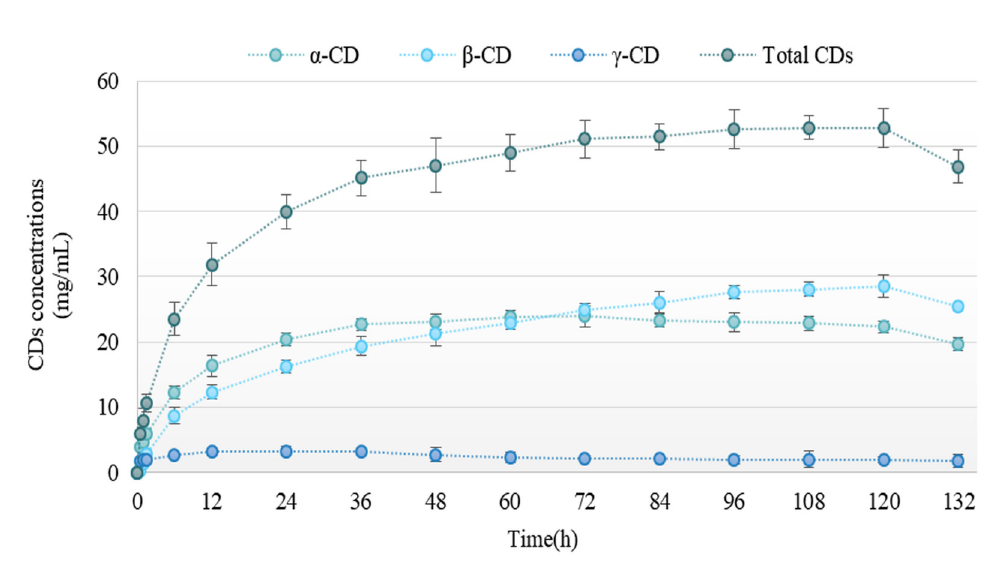
FIGURE 3 - Production of cyclodextrins over 132 h at 65 °C using 10% (w/V) cassava starch and 10% (V/V) ethanol as determined by